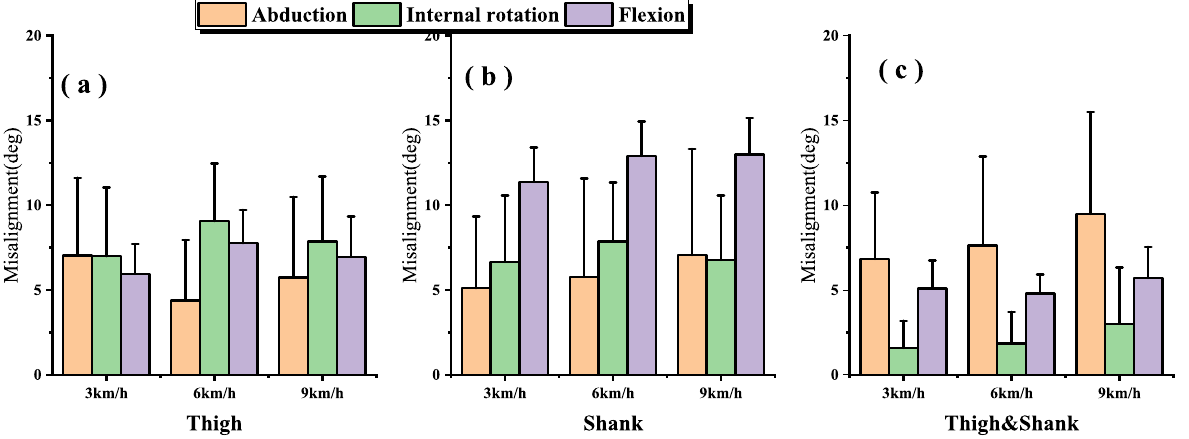
Figure 8. IMU to segment misalignment of all subjects. The bar and error bar represent the mean and standard deviation (SD) of the misalignment root mean square errors (RMSEs). ( a – c ) indicate the misalignment RMSEs of IMU to thigh misalignment, IMU to shank misalignment and IMU to thigh and shank misalignment, during different